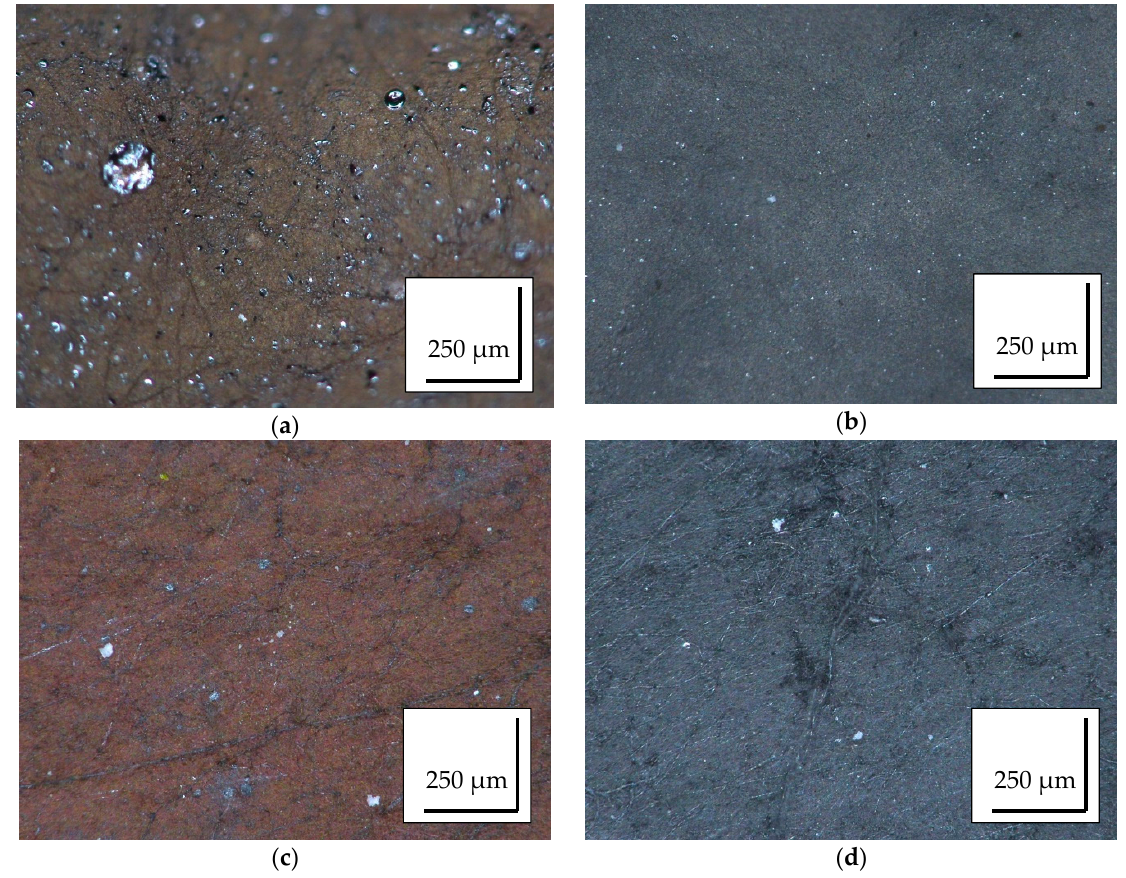
Figure 4. Microscopic images of ( a ) a stabilized PAN nanofiber mat; ( b ) a carbonized PAN nanofiber mat; ( c ) a stabilized PAN/ZnO nanofiber mat; ( d ) a carbonized PAN/ZnO nanofiber mat.